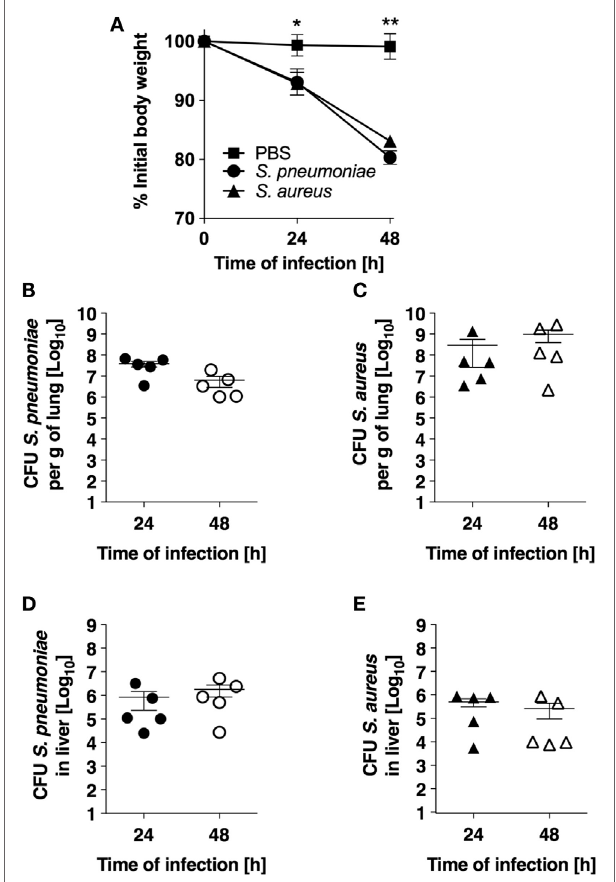
FigUre 1 | Infection parameters of pneumococcal and staphylococcal pneumonia in experimental murine models. (a) Body weight of BALB/c mice intranasally inoculated with either Streptococcus pneumoniae (circles) or Staphylococcus aureus (triangles). Mice intranasally treated with PBS were used as control (squares). Each symbol represents the mean value ± SD of 5–12 mice. * p < 0.05; ** p < 0.01. (B) Pulmonary bacterial loads in BALB/c mice after intranasal inoculation with S. pneumoniae. (c) Pulmonary bacterial loads in BALB/c mice after intranasal inoculation with S. aureus . (D) Bacterial loads in the liver of S. pneumoniae- infected mice. (e) Bacterial loads in the liver of S. aureus- infected mice. Each symbol represents an individual animal. One representative experiment out of three performed independently is